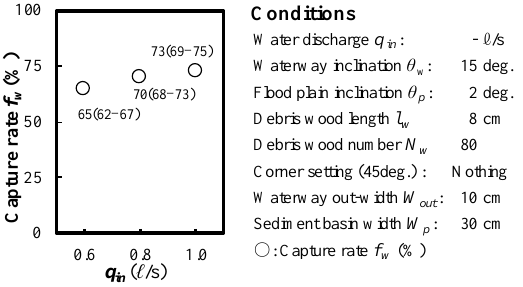
Figure 19. Effects of differences in the supply flow rate on the capture rate.